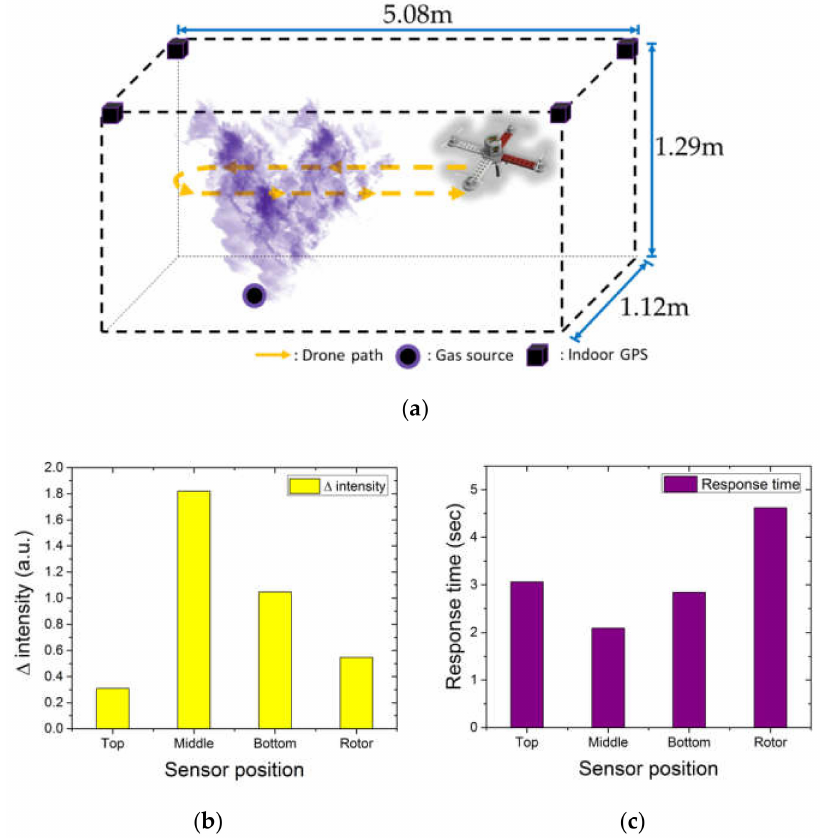
Figure 8. ( a ) Schematic of comparative sensor performance test, and ( b ) average capacitances and ( c ) sensor response times to DMMP at four di ff erent sensor positions on the